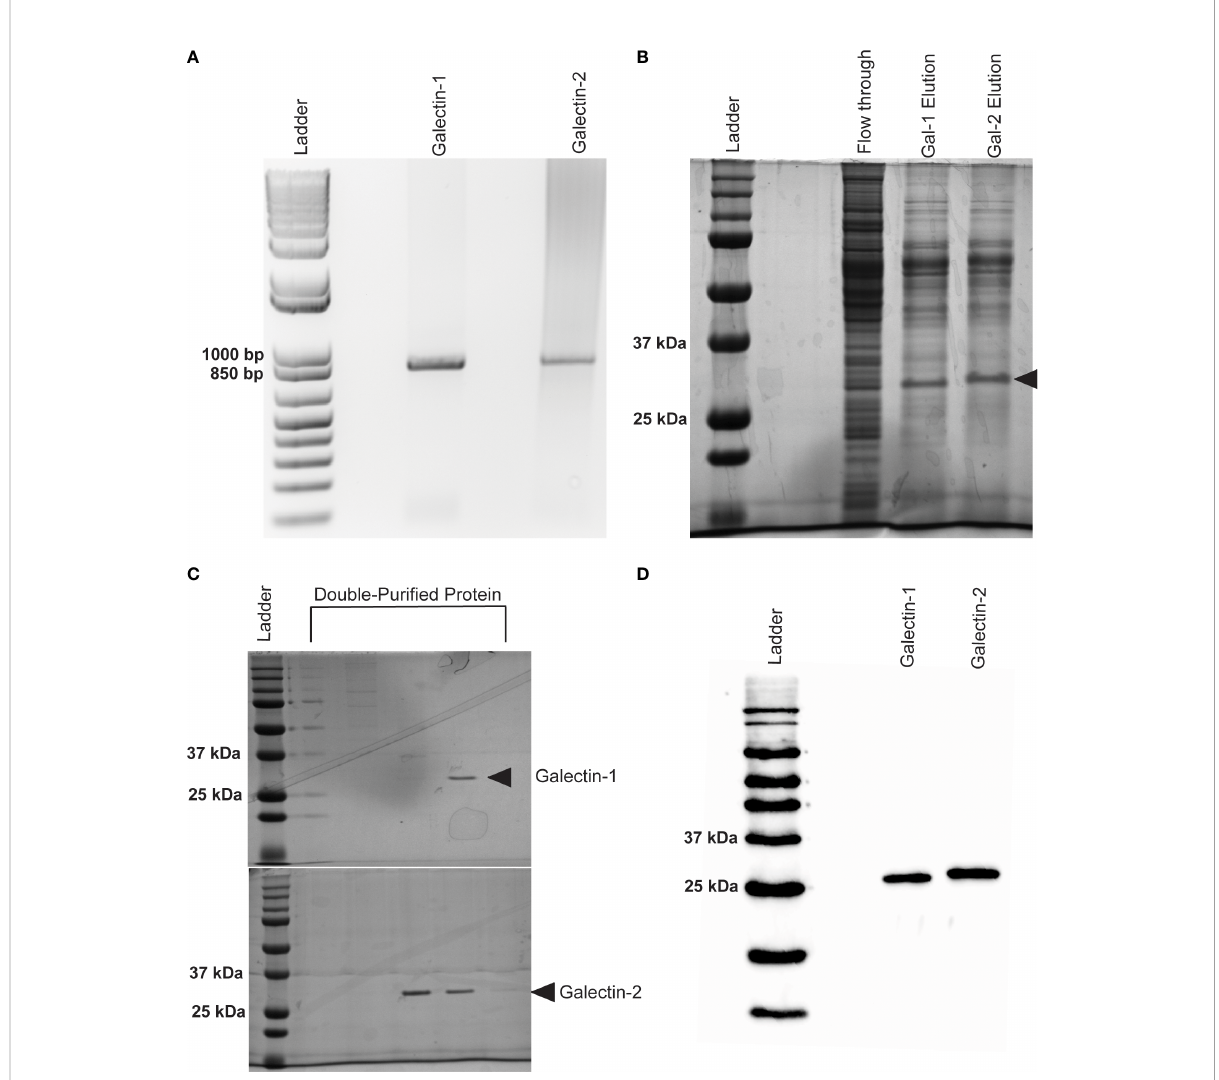
FIGURE 3 Expression of recombinant Bma-LEC-1 and Bma-LEC-2 in Sf21 cells. (A) DNA gel electrophoresis of Bma-LEC-1 and Bma-LEC-2 PCR amplicons from B. malayi adult female cDNA. (B) SDS-PAGE gel stained with Coomassie Blue showing elution of rBma-LEC-1 and rBma-LEC-2 expressing Sf21 cell lysates from initial nickel NTA resin puri fi cation and (C) after double puri fi cation using a FPLC system. Only clean FPLC fractions containing the protein of interest and no other debris or non-speci fi c proteins were used for downstream assays. (D) Final con fi rmation of concentrated, double-puri fi ed rBma-LEC-1 and rBma-LEC-2 was conducted via an anti-6x His Tag western blot. Black arrowhead referencing tagged recombinant galectins of the expected 32 kDa